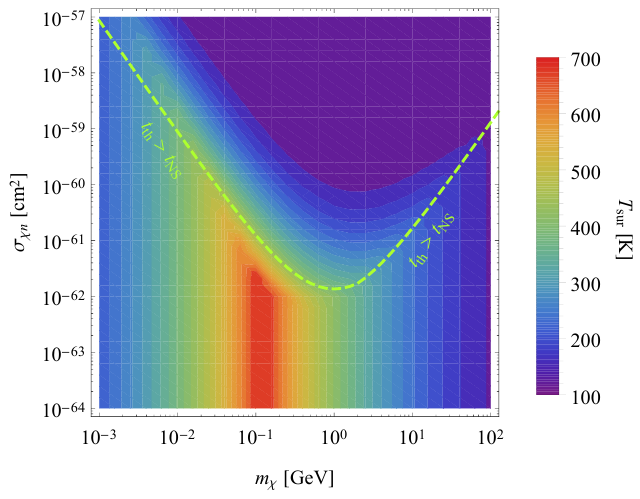
Figure 3 . A broad scan of T sur over m (cid:31) (cid:0) (cid:27) (cid:31)n plane. The corresponding DM self-interaction cross section and DM annihilation cross section are (cid:27) (cid:31)(cid:31) =m (cid:31) = 4 cm 2 g (cid:0) 1 and h (cid:27)v i = 3 (cid:2) 10 (cid:0) 26 cm 3 s (cid:0) 1 respectively. See main text for